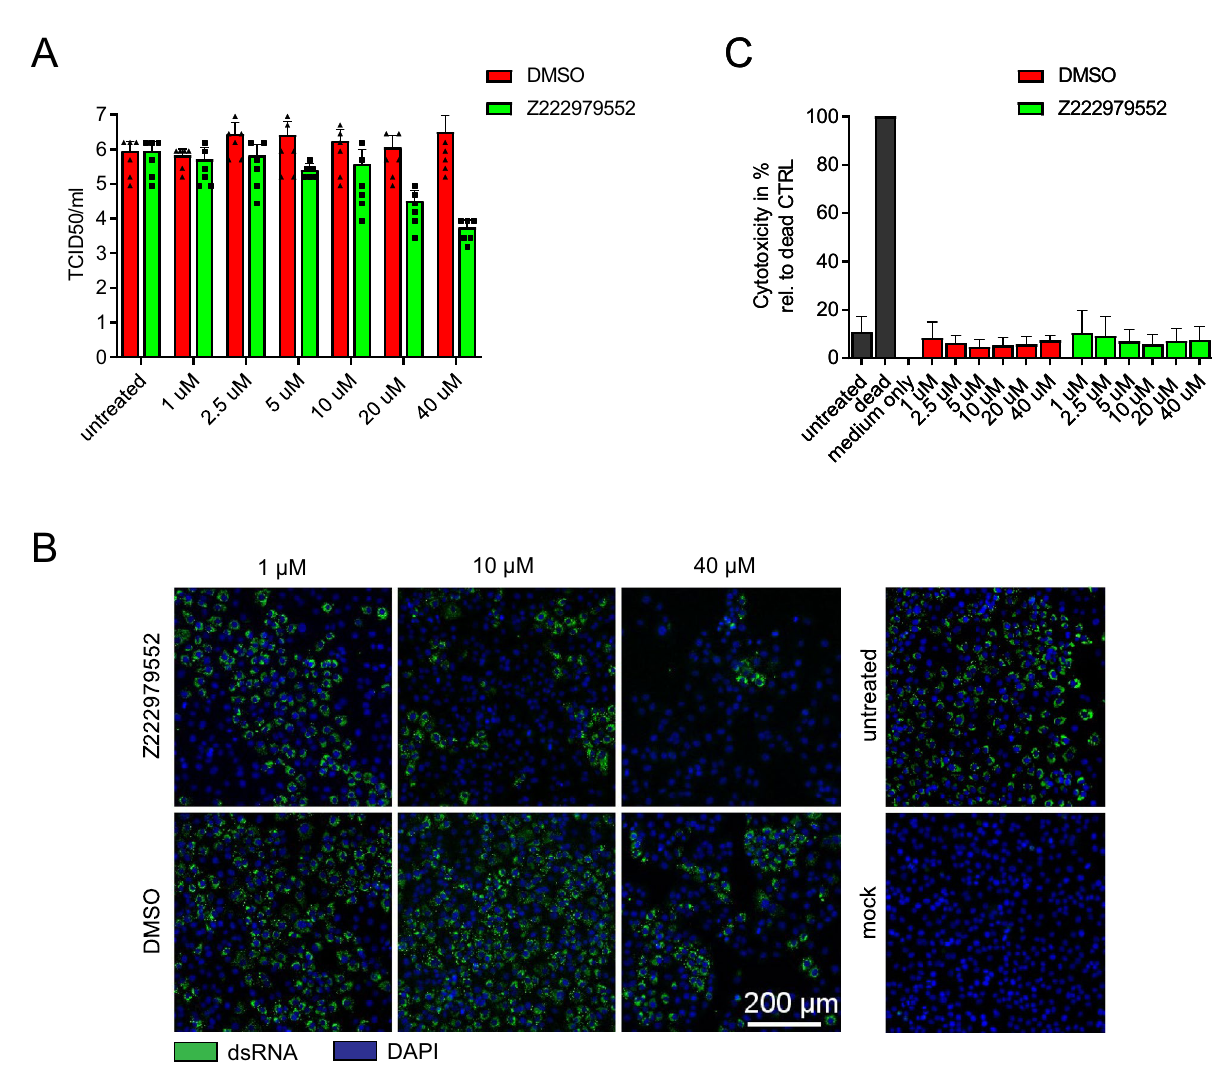
Figure 3. Compound Z222979552 reduces SARS-CoV-2 replication in Vero E6 cells in a dose-dependent manner. ( A ) SARS-CoV-2 titers upon treatment with compound Z222979552 or DMSO control. Viral titers are displayed as fifty-percent tissue culture infective dose (TCID 50 )/ml 24 h post-infection. TCID 50 values correspond to the viral titers (log 10 scale) required to kill fifty-percent of infected host cells. The experiment was performed in triplicate and the results are shown as means and standard deviations. ( B ) Immunofluorescence staining of infected Vero E6 cells for double-stranded RNA (dsRNA). The cells were treated with compound Z222979552 or DMSO and were stained 24 h post-infection. Green, dsRNA; blue, DAPI. One representative image out of three biological replicates is shown. ( C ) Z222979552-mediated cytotoxicity, determined using